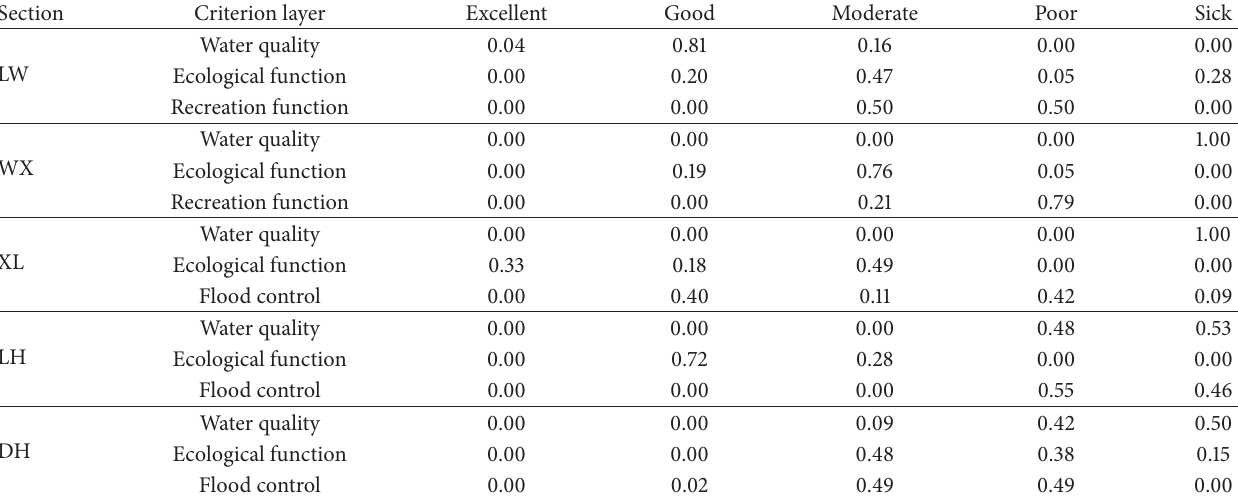
Table 2: The evaluation results for the criterion layer of Weihe River in Shaanxi Province. Section Criterion